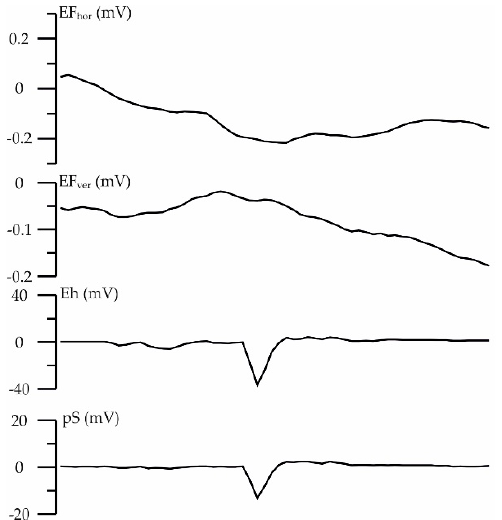
Figure 7. Anomalies EF (horizontal and vertical components), pS and Eh over the Logachev-1 field at 200 m from the bottom. 200 m from the